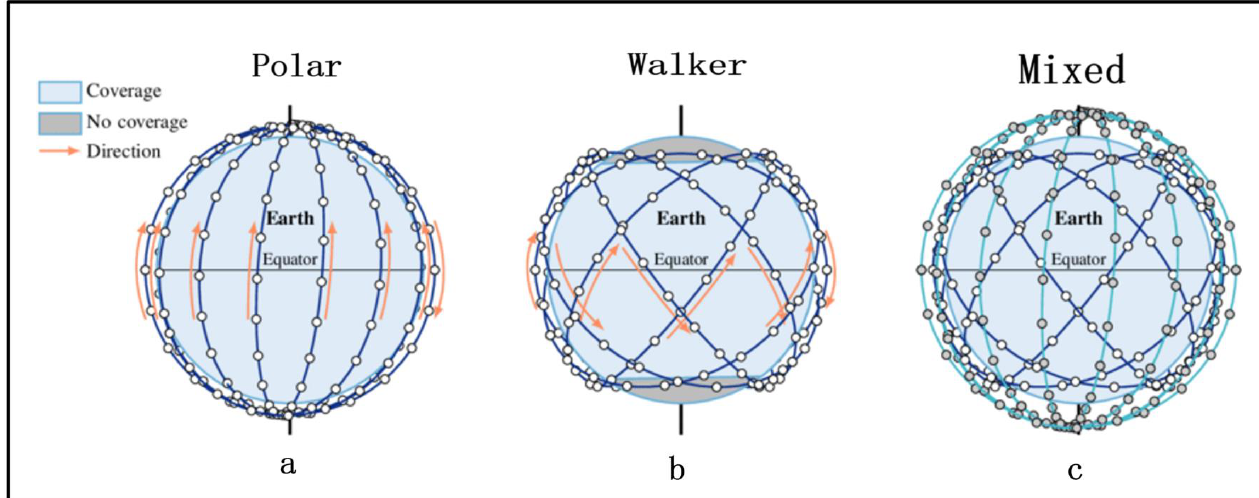
Figure 1. Symmetry constellation overview.